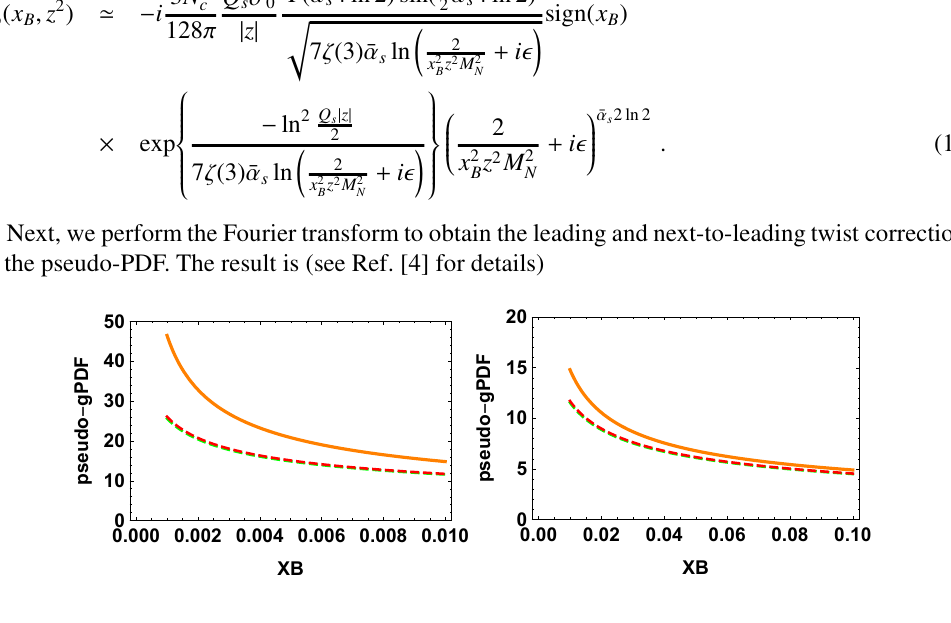
Figure 3. In the left panel we plot the pseudo-PDF with BFKL resummation (orange curve), and the LT (green dashed curve) and LT + NLT (red dashed curve) of the pseudo-PDF result; The value of x B is between 0.001 to 0.02. In the right panel we plot the same curves in a di ff erent range of x B i.e. between 0.01 to 0.1.